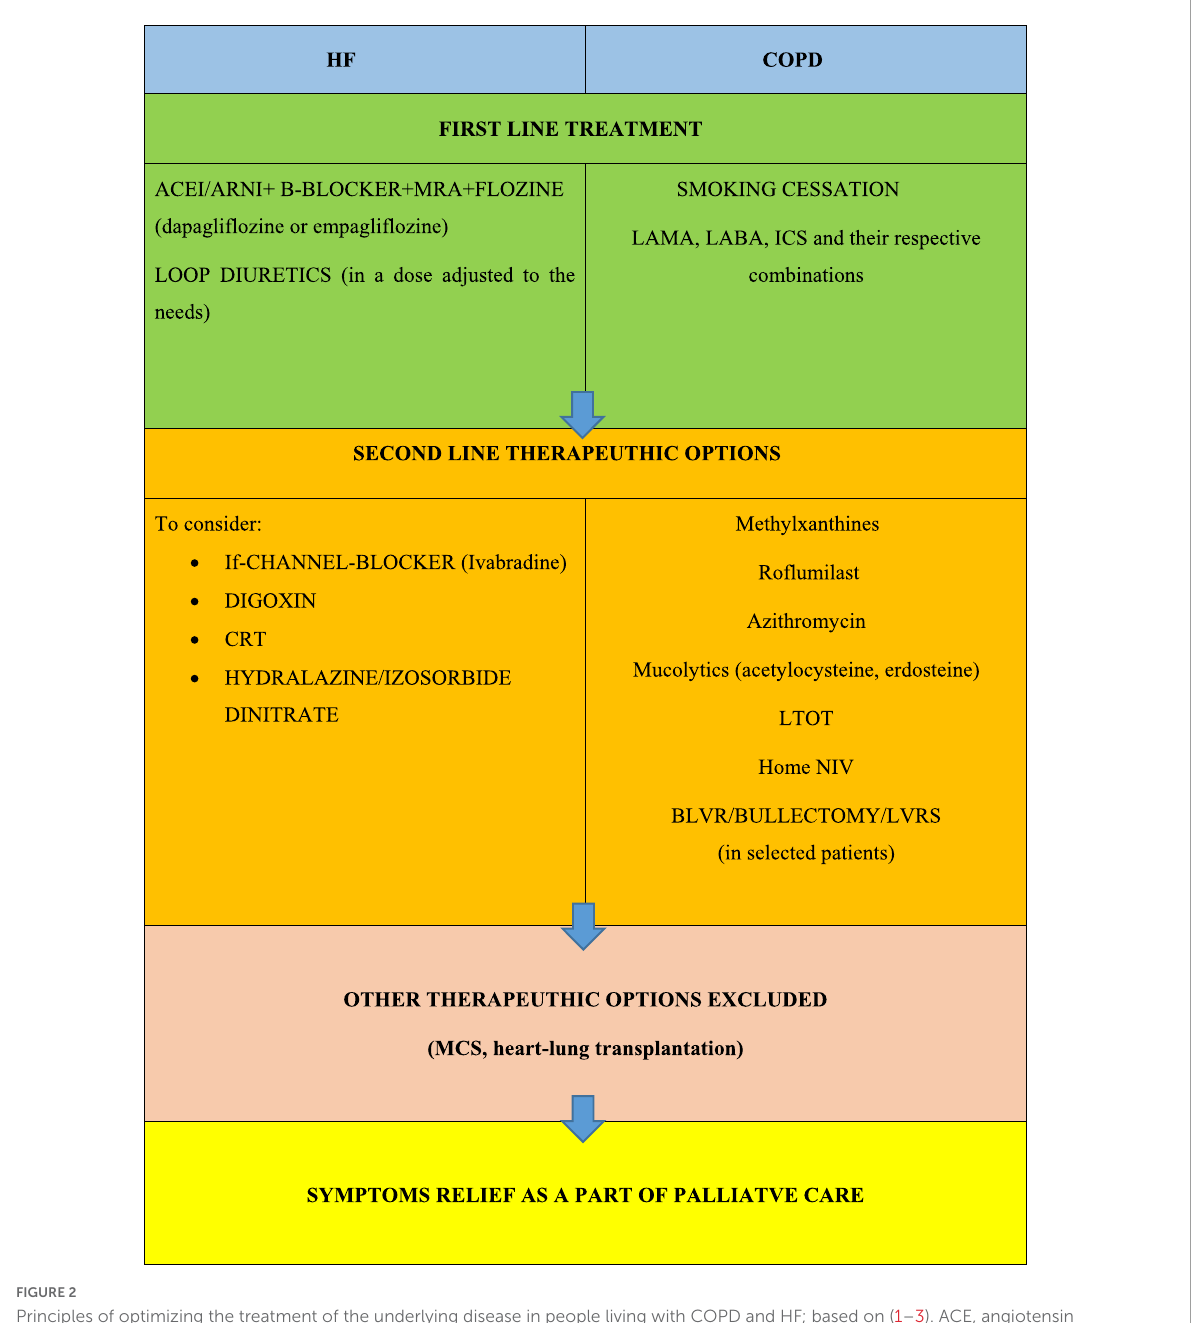
FIGURE2 Principles of optimizing the treatment of the underlying disease in people living with COPD and HF; based on (1–3). ACE, angiotensin converting enzyme inhibitor; ARNI, angiotensin receptor neprilysin inhibitor; BLVR, bronchoscopic lung volume reduction; COPD, chronic obstructive pulmonary disease; CRT, cardiac resynchronisation therapy; CS, corticosteroids; HF, heart failure; ICS, inhaled glucocorticoids; LABA, long acting B 2 agonist; LAMA, long acting muscarinic antagonist; LTOT, long term oxygen therapy; LVRS, lung volume reduction surgery; MCS, mechanical cardiac support; MRA, mineralocorticoid receptor antagonist; NIV, non-invasive ventilation; PDE-4, phosphodiesterase-4; SABA, short acting β